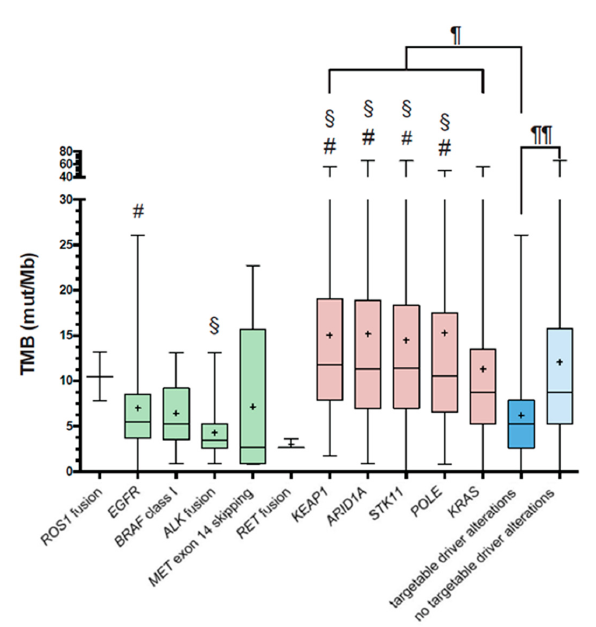
Figure 6. TMB and clinically relevant genetic alterations. For targetable driver alterations (green and blue), TKI-sensitive mutations were counted. Regarding KEAP1 , ARID1A , STK11 , and POLE , all non-synonymous aberrations (red) were considered. Data are presented as box plots with a 95% confident interval. The line indicates the mean, the + indicates the median. Statistical analysis by ANOVA revealed significant di ff erences in TMB between EGFR and KEAP1 , ARID1A , POLE , and STK11 (#) mutated groups; between ALK fusion and KEAP1 , ARID1A , POLE , and STK11 mutated groups (§); and between targetable driver mutations and all red groups (¶); and lastly, between targetable and non-targetable driver mutation groups